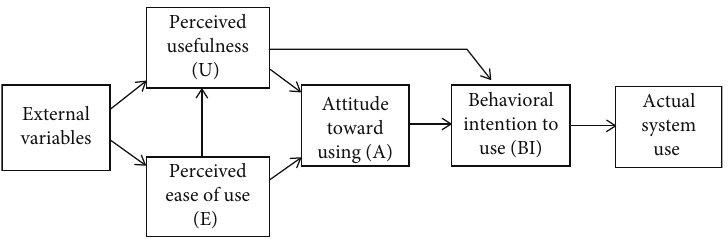
Figure 6: First modi fi ed version of technology acceptance model (TAM) [29].